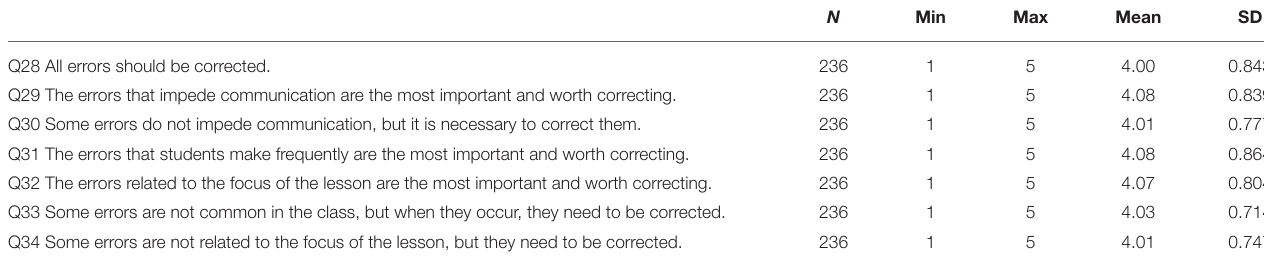
TABLE 1 | Students’ beliefs about targets of oral corrective feedback.